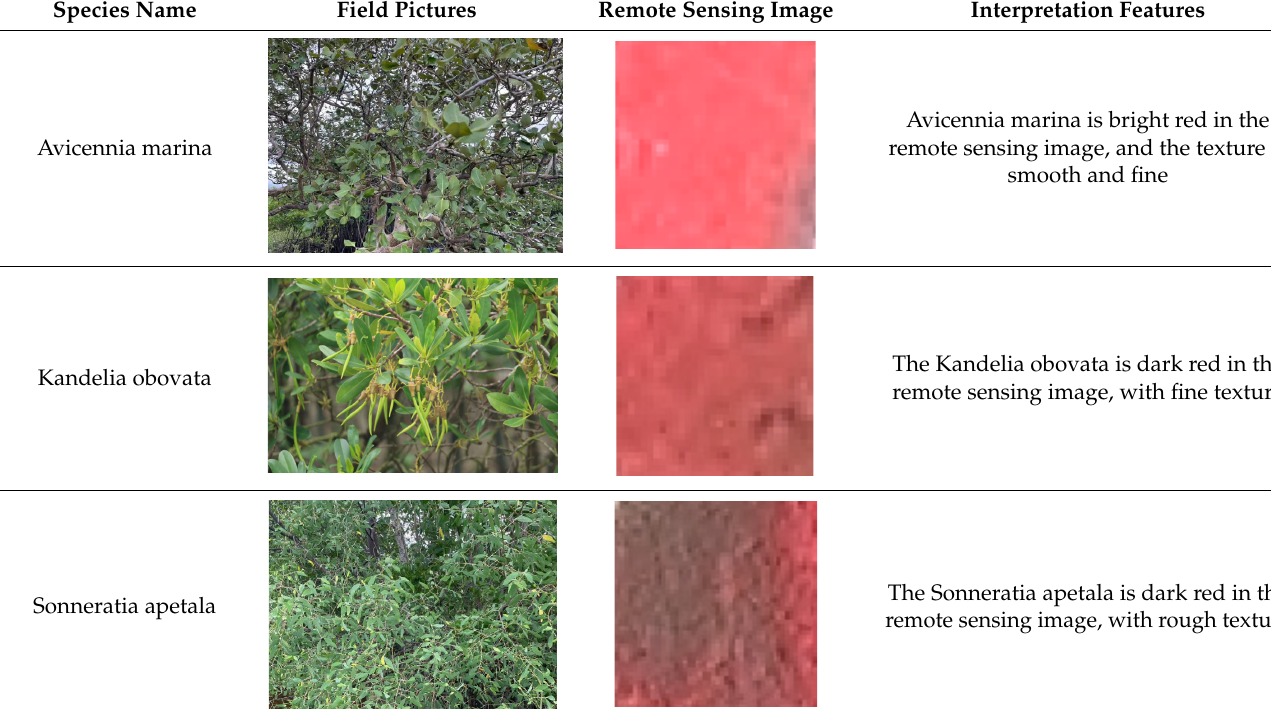
Table 1. Interpretation marks of different mangrove species.